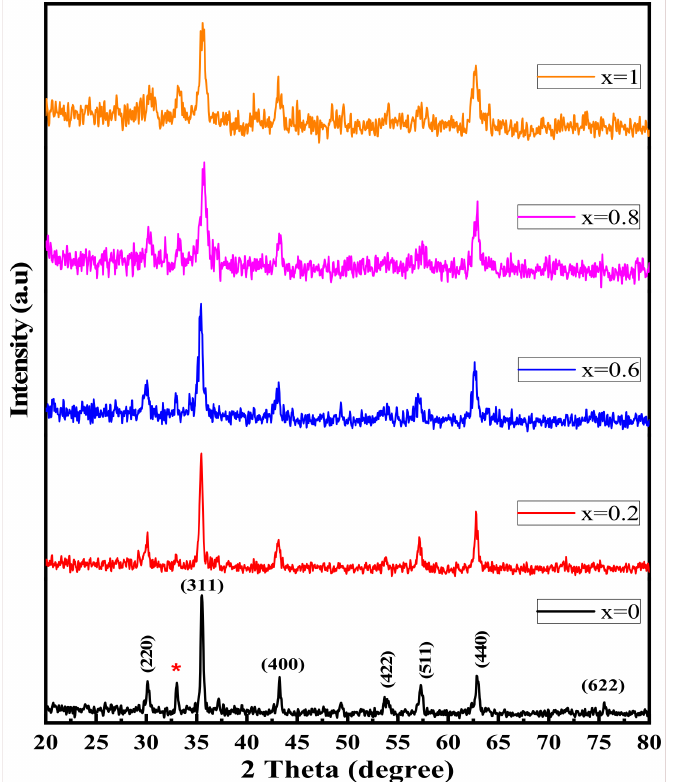
Figure 1. XRD patterns of Ni + 2